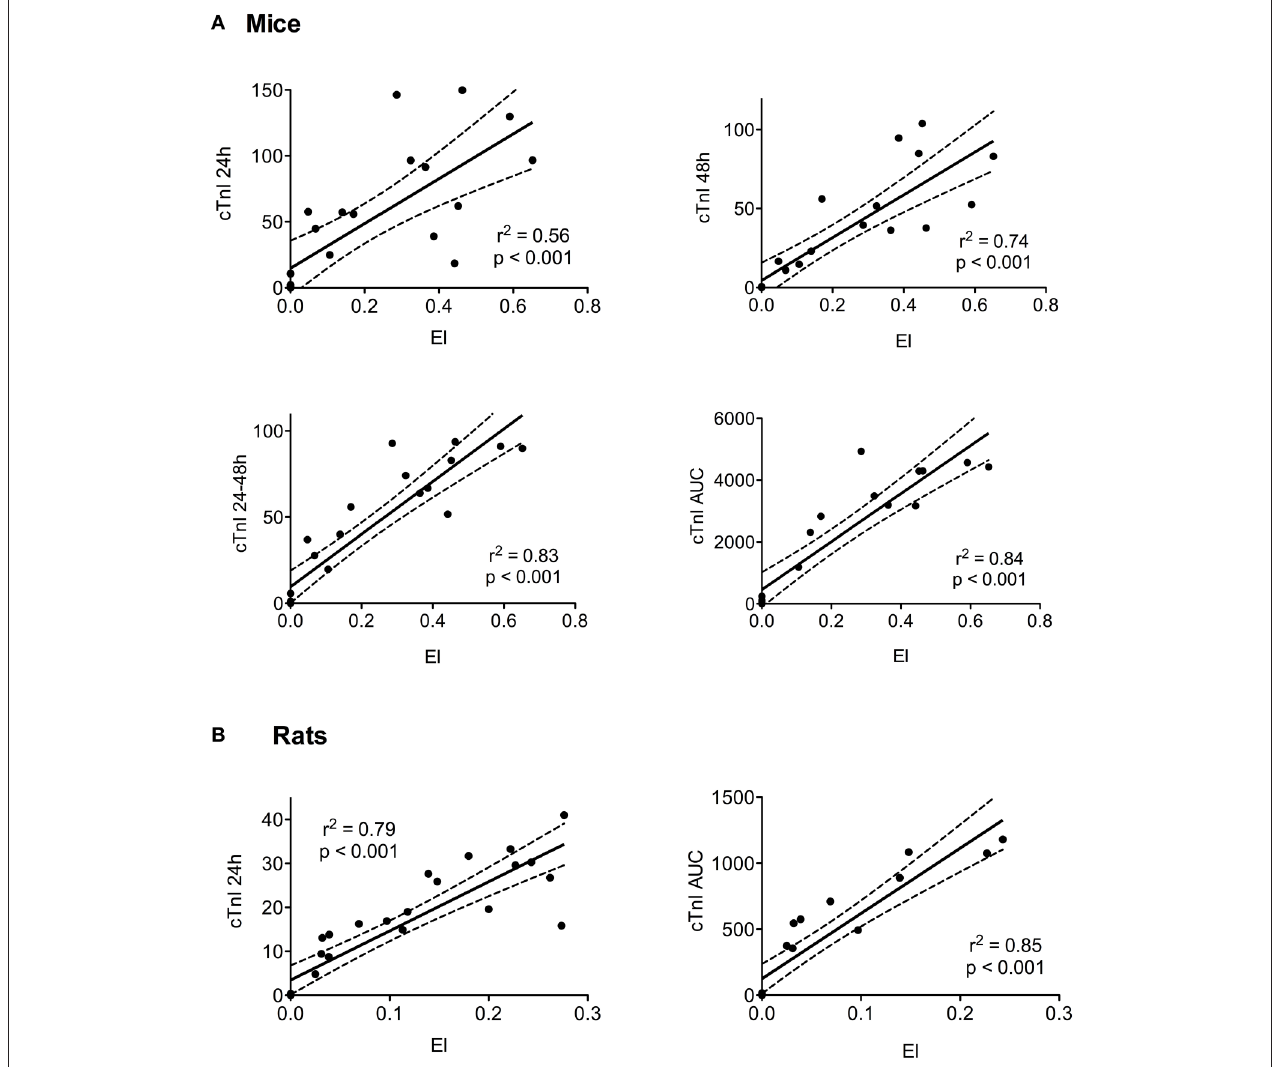
FIGURE 4 | Relationship between the expansion index (EI) and cTnI level: the EI was measured in all animals, including the healthy controls, sham-operated, and infarcted animals, 6 weeks after surgery in the mice (A) and rats (B). The cTnI concentrations are presented at 24 and 48h, as the mean of the 24–48h time period, and as the AUC. The r 2 and p -values from the regression and correlation analyses are shown for each graph. The linear regression (black line) and 95% confidence intervals (dotted lines) are represented.